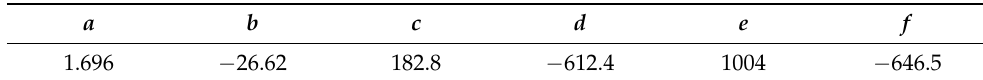
Figure 13. The relationship between C and ε . Table 3. Reported parameters of the C ( ε